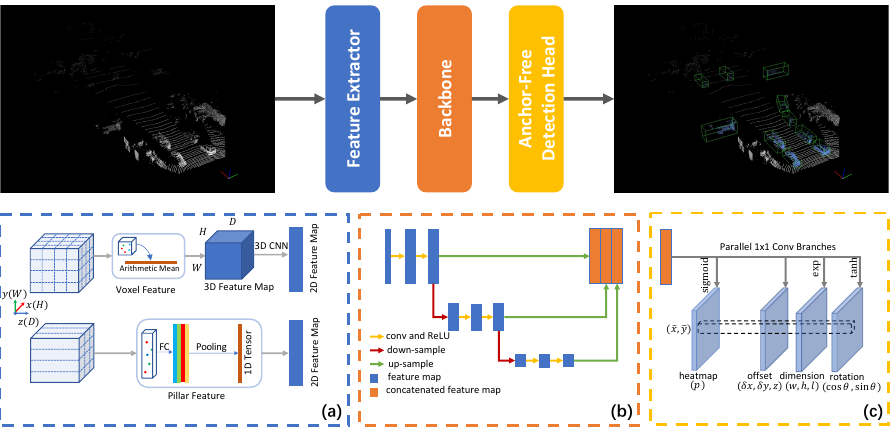
Figure 1. Our network architecture contains three modules. ( a ) We generate a 2D point cloud feature map with the pillar/voxel feature extractor. ( b ) Our backbone network consists of convolutional and deconvolutional blocks to extract multi-level semantic information. Note that the down-sampling factor can be one in application. ( c ) Our anchor-free detection head obtains the heatmap and absolute 3D additional information of the target through the fully convolutional